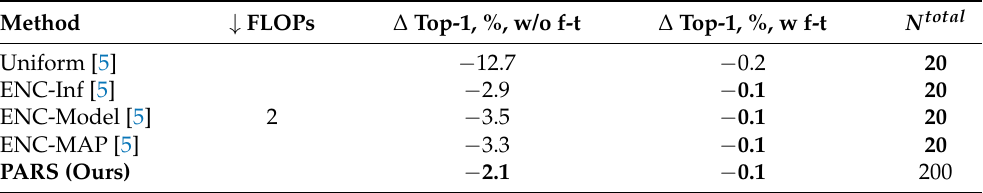
Table 4. Comparison of different rank search methods for the Spatial-SVD compression of ResNet-56 on the CIFAR-10